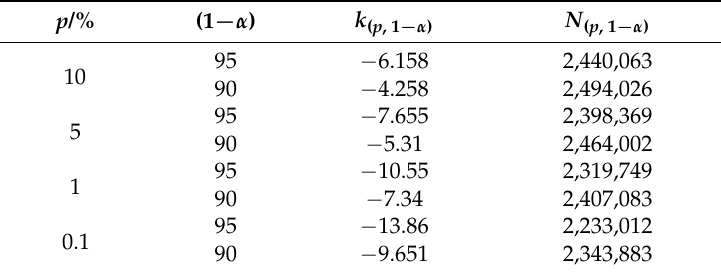
Table 4. Statistical analysis of the fatigue